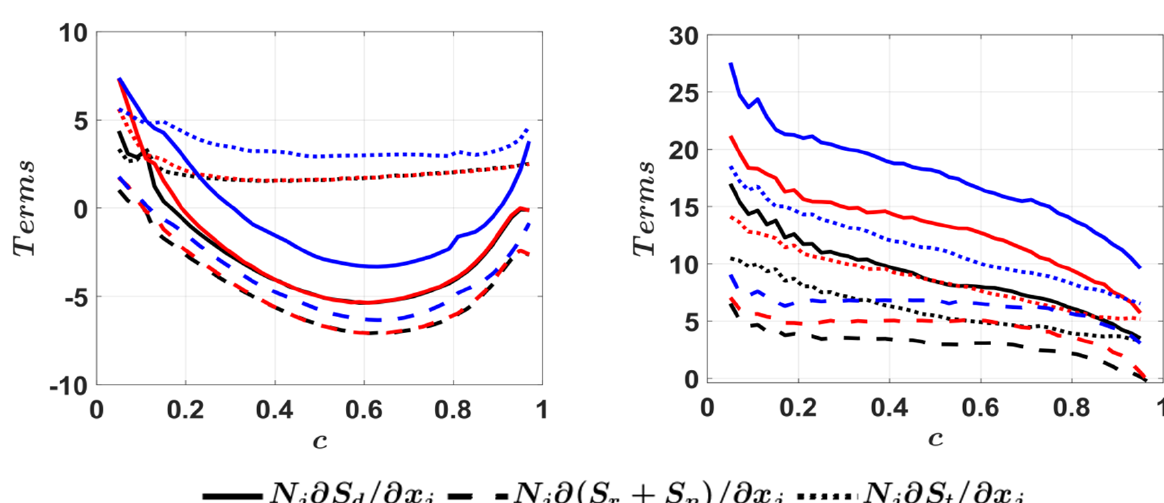
Figure 10. Profiles of the normalised mean values of the additional flame normal strain rate due to flame propagation ( N j ∂ S d / ∂ x j × δ th / S L ) and its components (i.e., N j ∂ ( S r + S n ) / ∂ x j × δ th / S L and N j ∂ S t / ∂ x j × δ th / S L ) conditioned upon c for u (cid:48) / S L = 4.0 (black) 6.0 (red) and 8.0 (blue) for statistically planar turbulent premixed flames (first column) and homogeneous MILD combustion cases (second column). Note the difference in scales between premixed flame and MILD combustion cases.